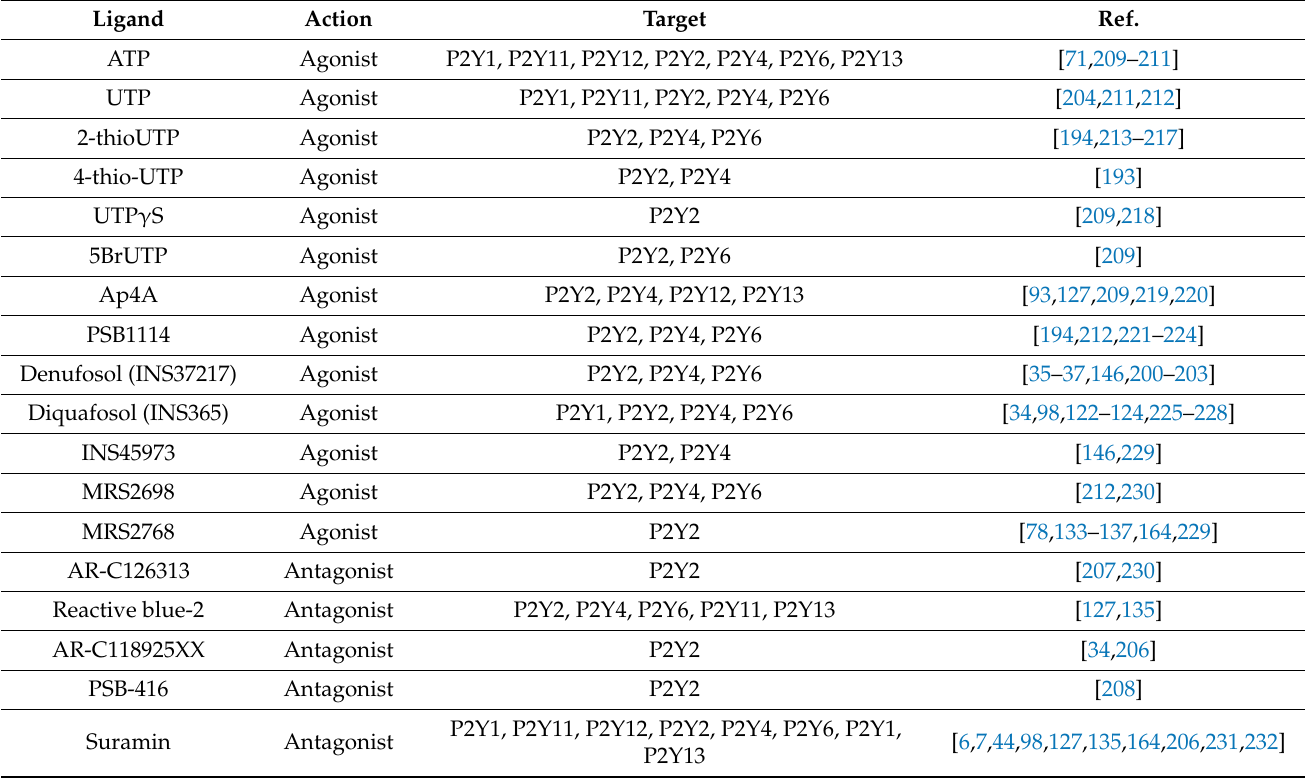
Table 2. P2Y2 specific and non-specific ligands.